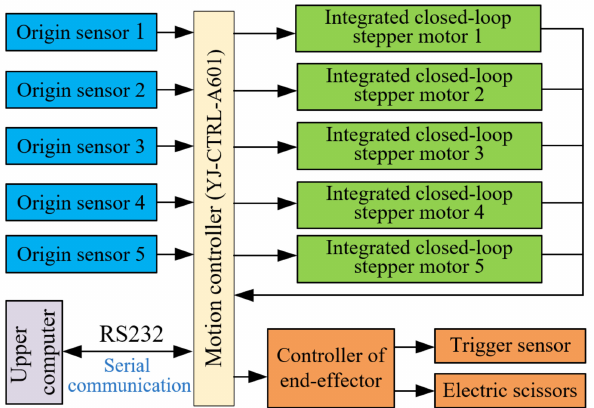
Figure 7. The diagram for the overall control scheme of the jujube pruning manipulator.